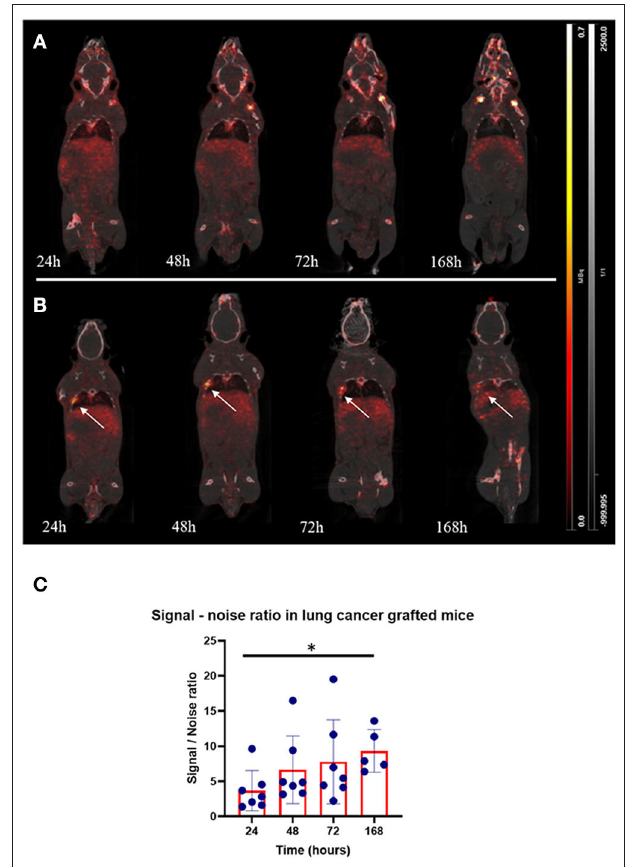
FIGURE 3 | Preclinical imaging of [ 89 Zr]DFO-anti-PDL1 in healthy and lung cancer-grafted mice. (A) Healthy mice after IV injection of [ 89 Zr]DFO-anti-PDL1 at four times: 24, 48, 72, and 168h. (B) Lung cancer-grafted mice after IV injection of [ 89 Zr]DFO-anti-PDL1 at four times: 24, 48, 72, and 168h. (C) Signal-to-noise ratio (SNR, tumour concentration/lung concentration). Kruskal-Wallis test (* p <